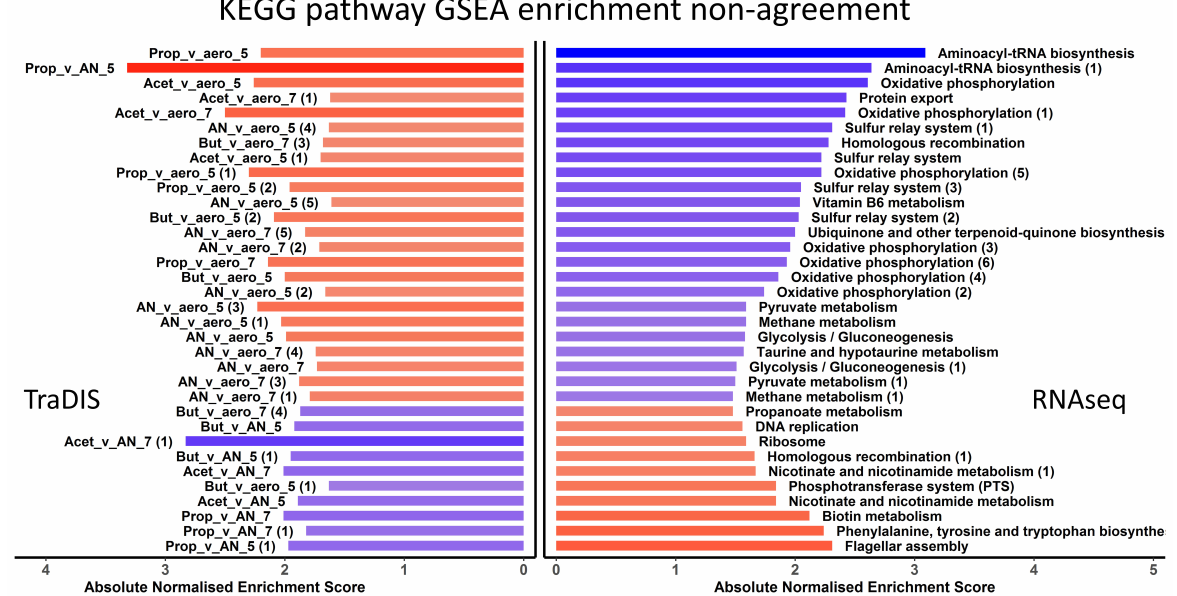
Figure 9. A total of 34 cases where TraDIS and RNAseq KEGG pathways gave opposite enrichment results for the same condition. The horizontal bars represent absolute normalised enrichment scores, where rows across both bar plots represent the same KEGG pathways enriched for both TraDIS and RNAseq, respectively. Text in the left bar plot shows the contrasted conditions where the different enrichments occurred, and the text in the right bar plot shows the KEGG pathway name. The numbers in brackets on the left bar plot represent contrasts that had multiple KEGG pathways disagreements between RNAseq and TraDIS. As an example, the contrast Anaerobic vs. aerobic at pH5.5 disagreed for 6 different KEGG pathways. The colour blue represents negative enrichment (i.e., enrichment of the KEGG pathway in the control sample) and the red colour represents enrichment in the stress condition samples. The darkness of the colour corresponds to the significance of